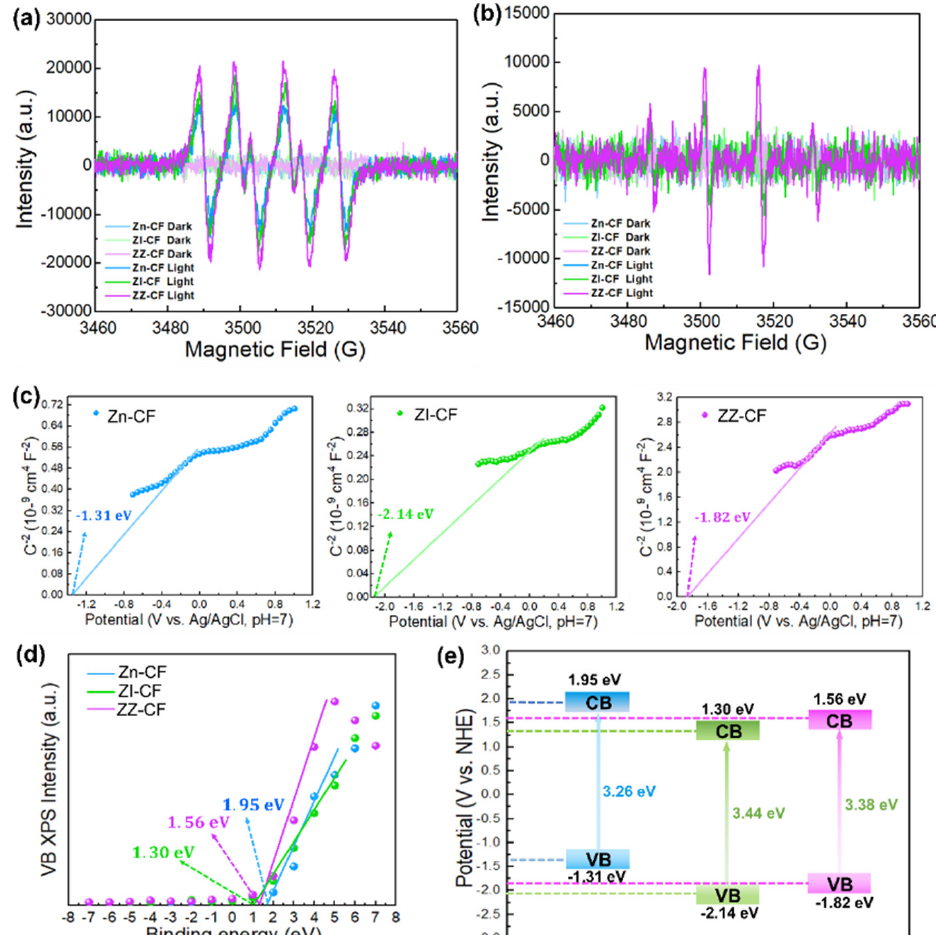
Figure 6. ( a , b ) EPR spectra of Zn–CF, ZI–CF, and ZZ–CF for ·O 2 − and ·OH, respectively; ( c ) Mott– Schottky plots of Zn–CF, ZI–CF, and ZZ–CF at 1000 Hz; ( d ) VB XPS of Zn–CF, ZI–CF, and ZZ–CF; ( e ) The band alignments versus the normal hydrogen electrode (NHE) for Zn–CF, ZI–CF, and ZZ–CF.